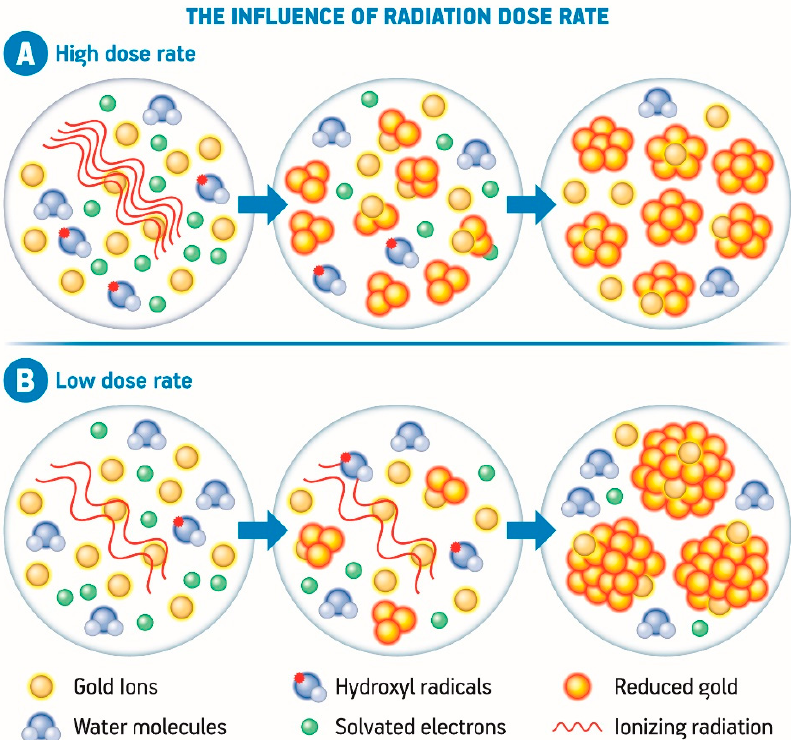
Figure 4. Representative scheme of the influence of high dose rate ( A ) and low dose rate ( B ) over the nucleation and growth of gold nanoparticles generated by the radiolytic synthesis using high energy radiation (Adapted from [108,109]).